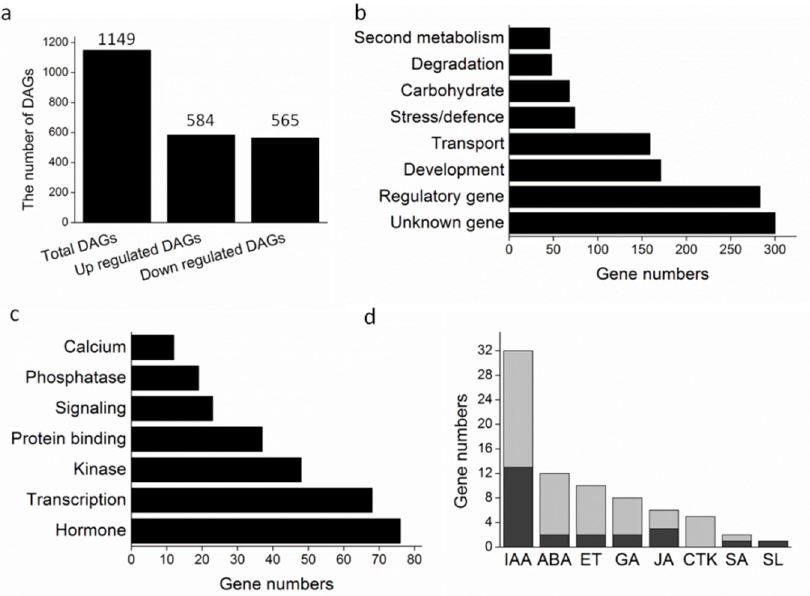
Figure 3. DRL1 regulates various genes associated with leaf senescence. ( a ) The number of DEGs in DRL1-overexpressing transgenic plants compared with wild type plants. ( b ) Classification of DAGs based on Gene Ontology (GO) annotation. ( c ) Classification of regulatory genes. ( d ) Classification of hormone-related genes (gray columns represent up-regulated genes, black columns represent down-regulated genes).